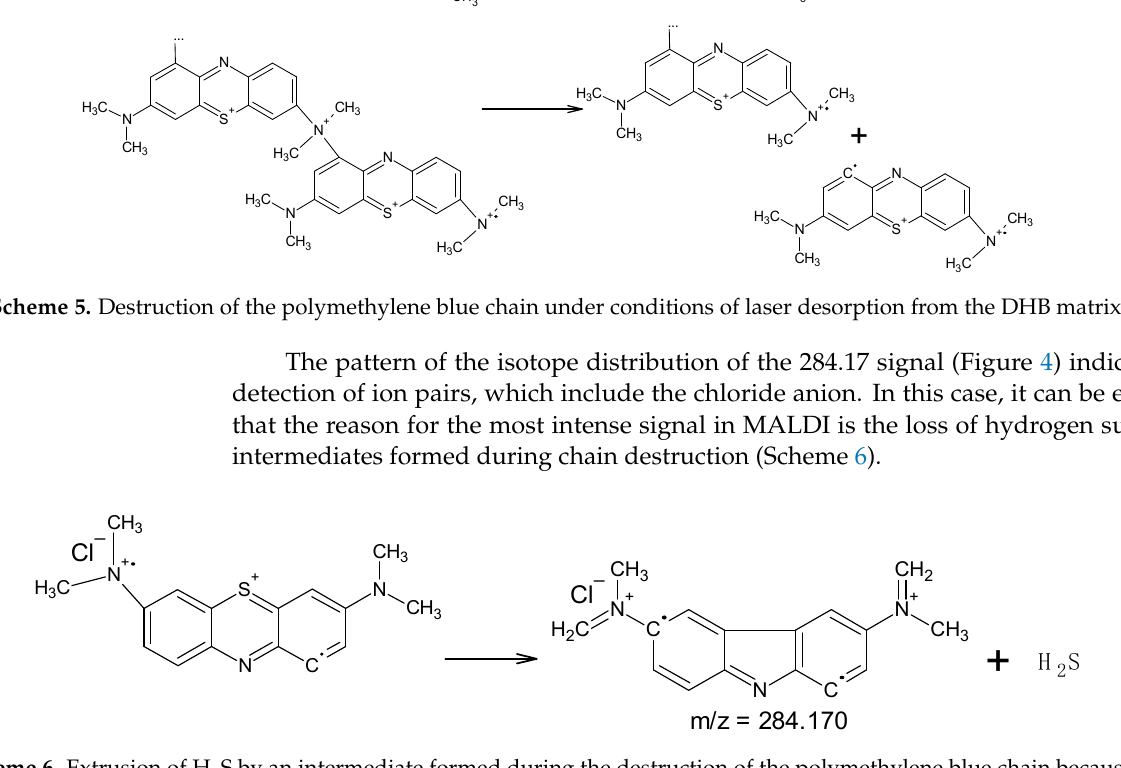
Scheme 6. Extrusion of H 2 S by an intermediate formed during the destruction of the polymethylene blue chain because of laser desorption from the DHB matrix.